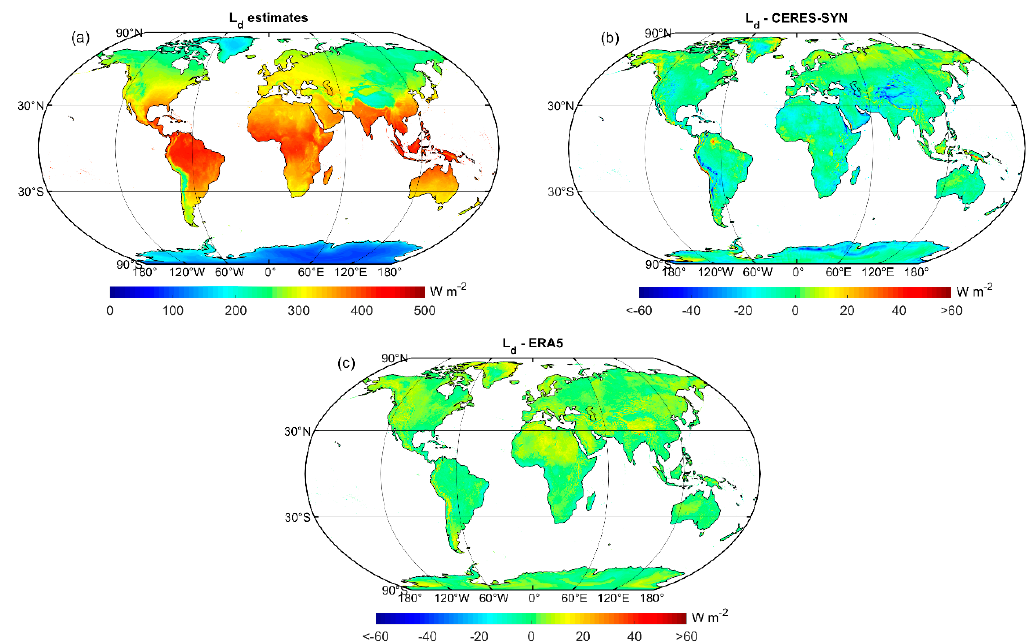
Figure 8. The spatial distribution of the multiyear seasonal mean value of the generated L d dataset in Northern hemisphere ( a ) spring (March, April, and May), ( b ) summer (June, July, and August), ( c ) autumn (September, October, and November), and ( d ) winter (December, January, and February) over the global land surface from 2003 to 2018.